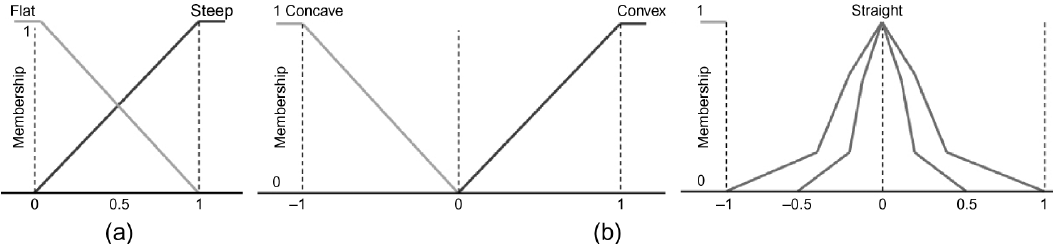
Figure 8. Membership functions used for fuzzy classification of basic landform classes. Membership function for ( a ) steepness or flatness and ( b ) curvedness or straightness.